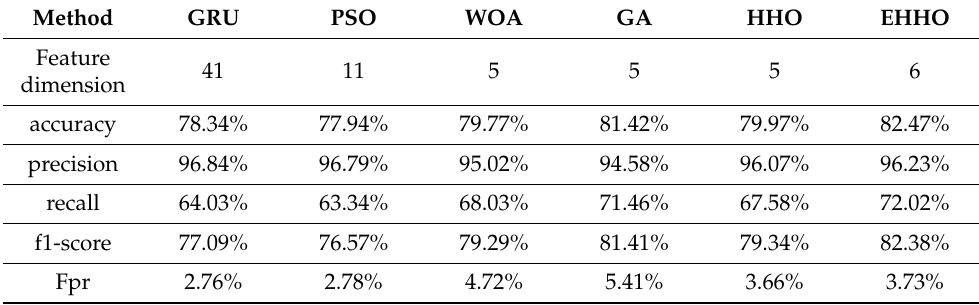
Table 7. Experimental results of NSL-KDD binary classification.